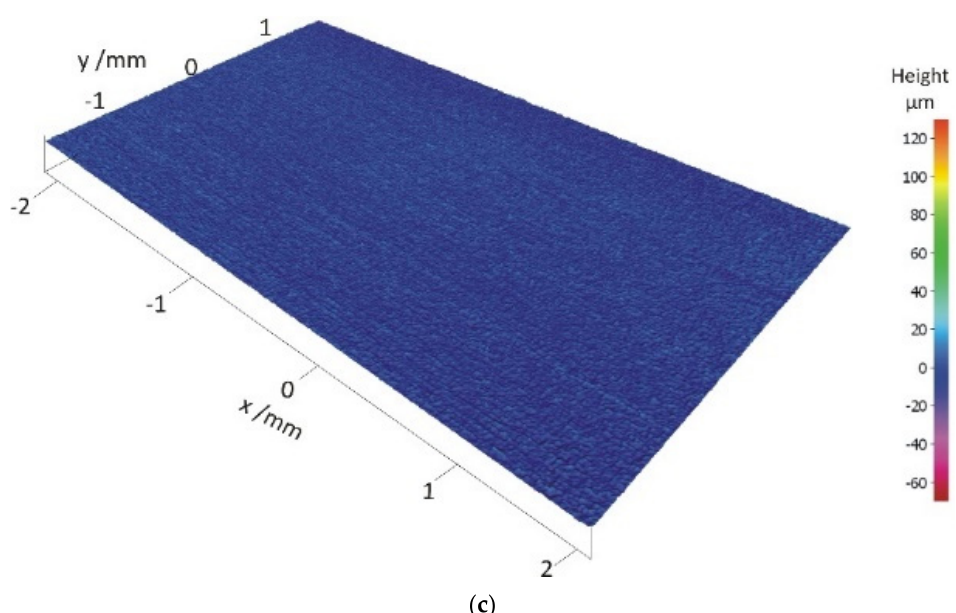
Figure 7. Surface morphology and roughness of the analysed casting’s surfaces: degraded ( a ), undegraded ( b ), and cross-section of the freshly cut casting ( c ).